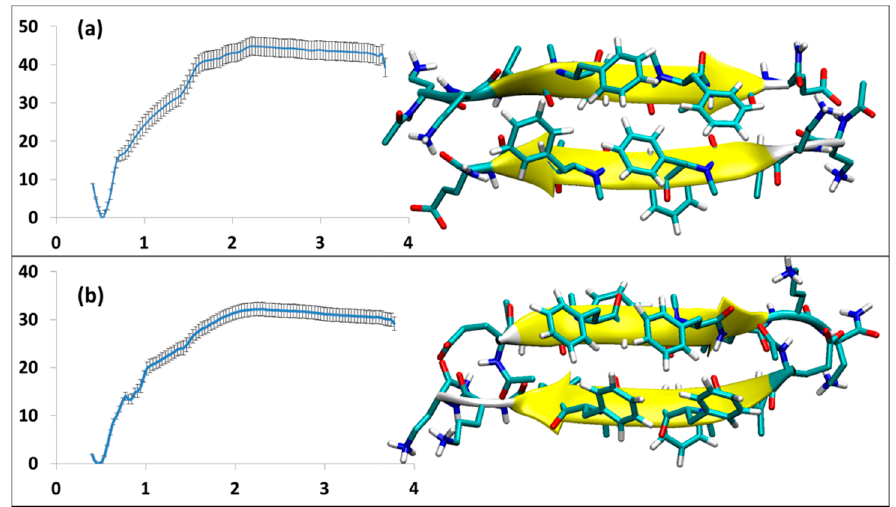
Figure 4. The homodimers; the structures and the related PMF curve: ( a ) SGB1-self ( b ) SGD1-self.